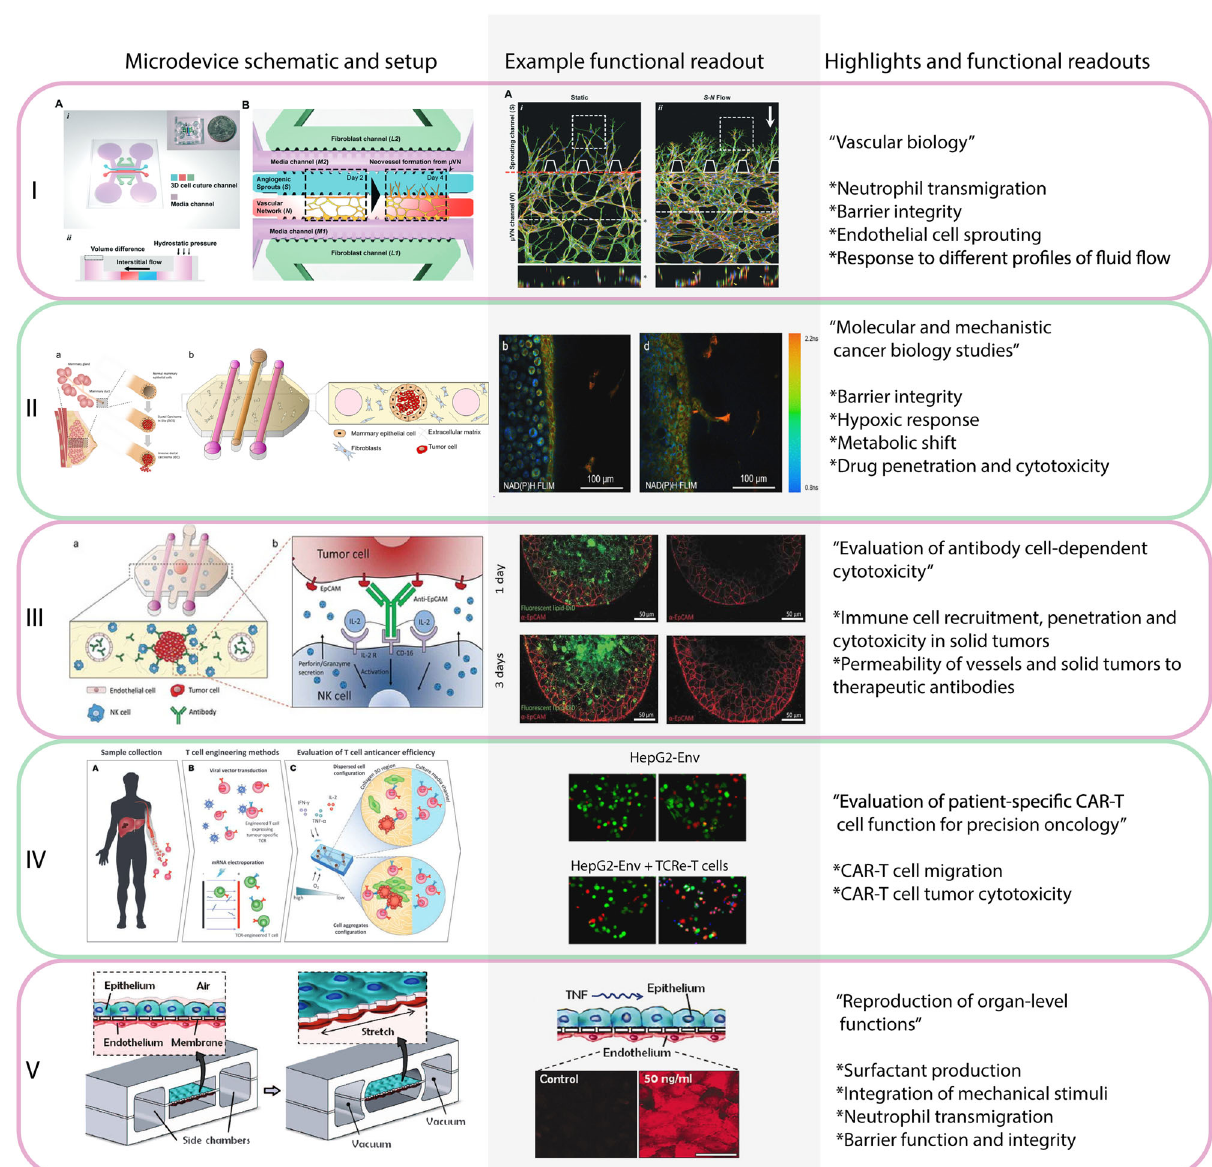
Fig. 1 Representative micro fl uidic models for functional analysis. The fi gure shows schematic representations of the model (left column), a microscopy image of a functional output of the model (middle column), main highlights of the model, and functional assays demonstrated (right column). Chimeric- antigen receptor (CAR) T cells 25,41,57,121,122